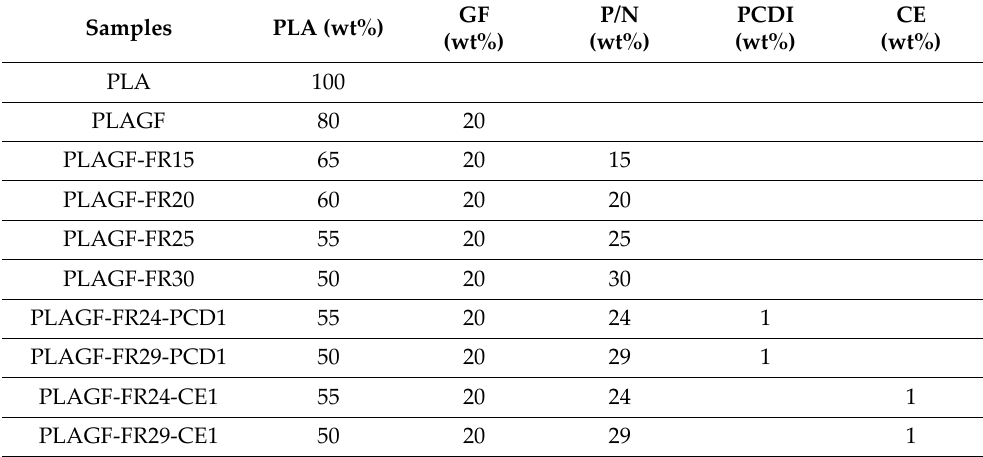
Table 2. PLA and PLA composite with PN FR and with/without chain